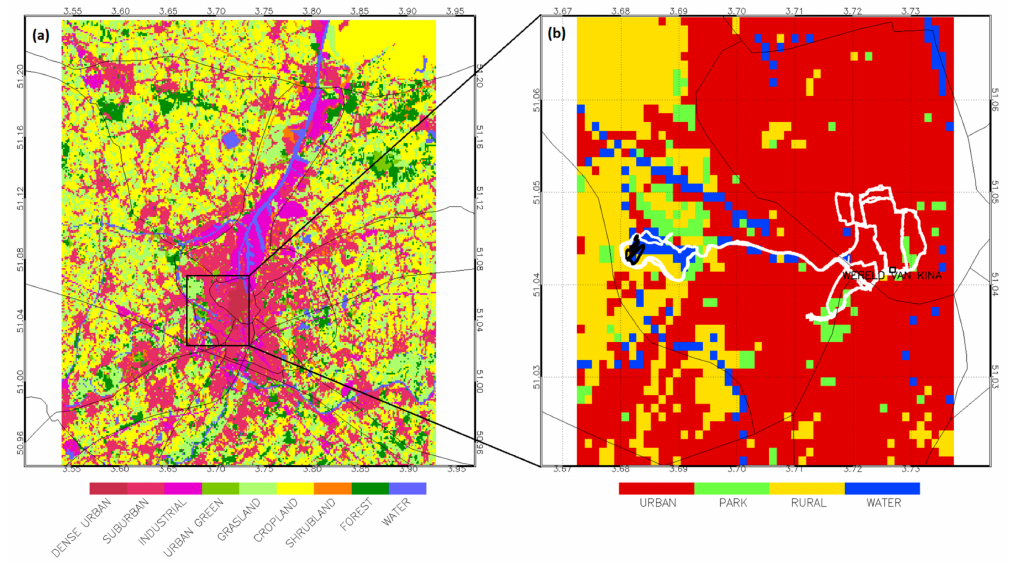
Figure 1. Extent and land use classification of the UrbClim model domain ( a ) and the focus area of this study around the measurement locations ( b ). The location of the observational station and the trajectories of the cycling (white) and boating (black) measurements are shown in the panel on the